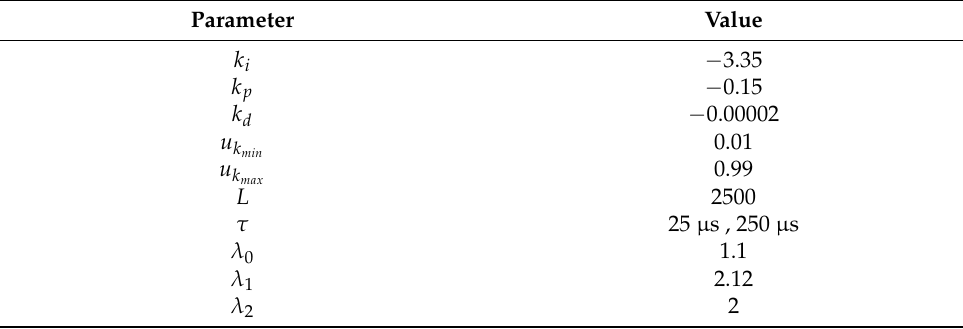
Table 3. Control gains and parameters of the